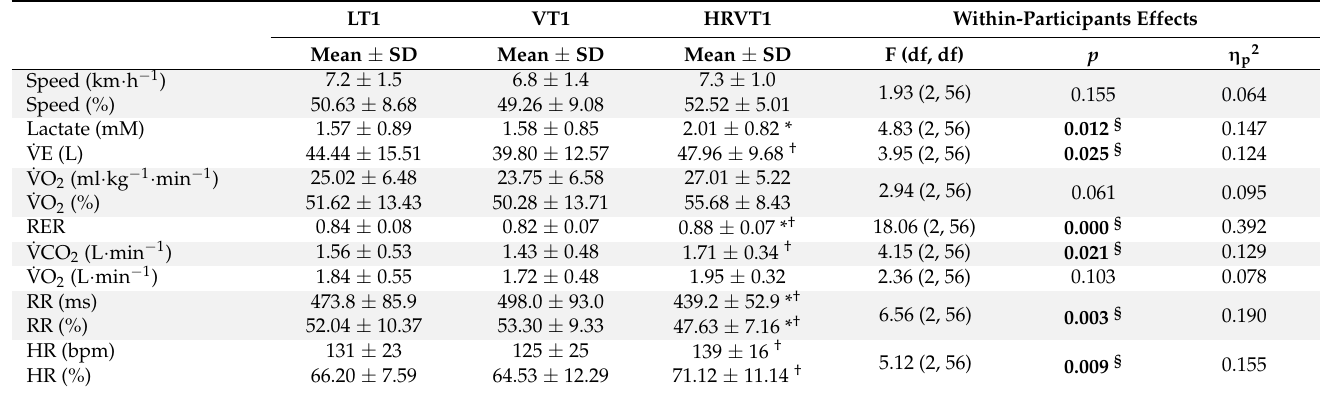
Table 2. Comparison between the means of the methods for identifying thresholds 1 in CPxS.